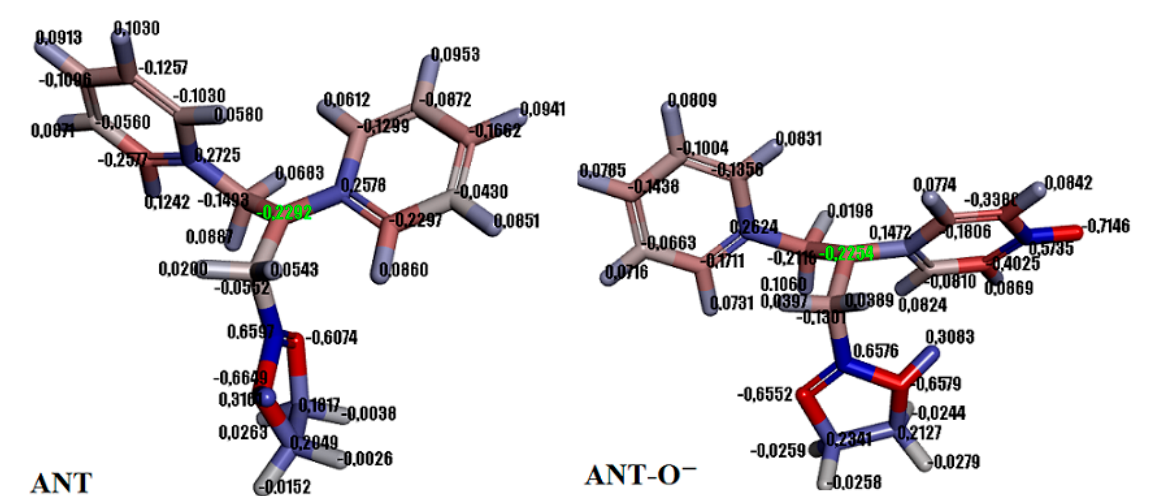
Figure A1. Distribution of atomic partial charges (ESP) in the molecules of ANT and ANT-O – . Molecules colored according to the partial charge values—negative values are shown as red and positive values as blue.